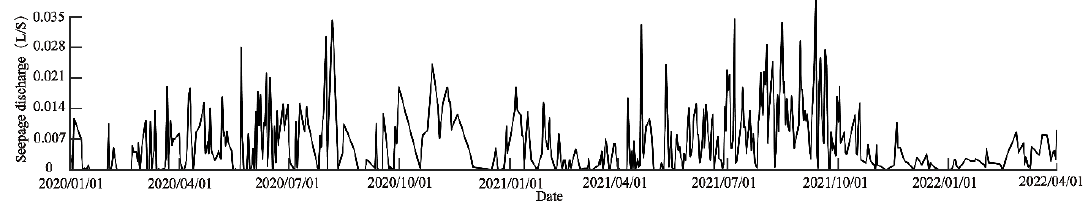
Figure 13. Process line of foreign water of seepage discharge at measuring point WE01ZXD.